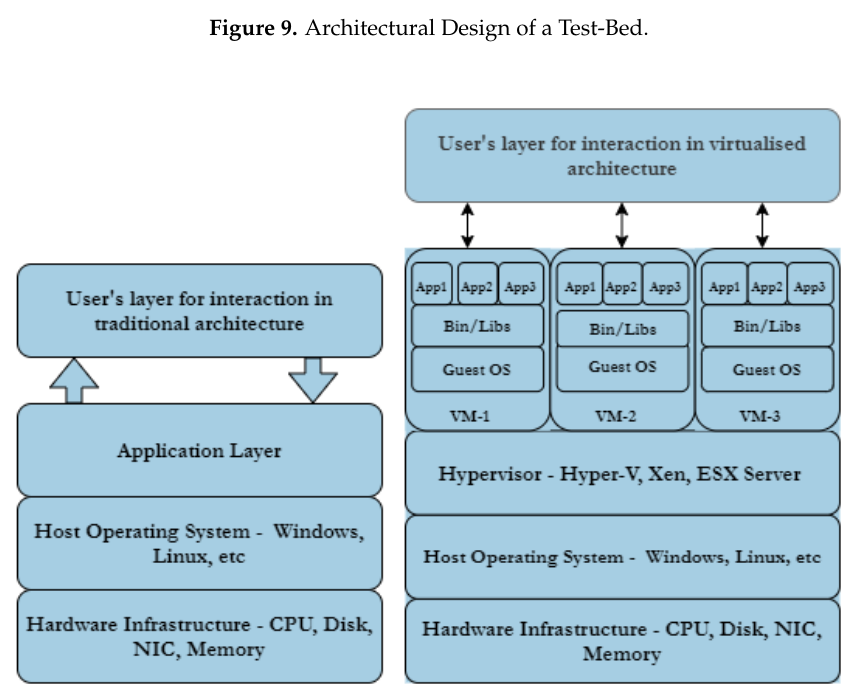
Figure 10. Hybrid Computing